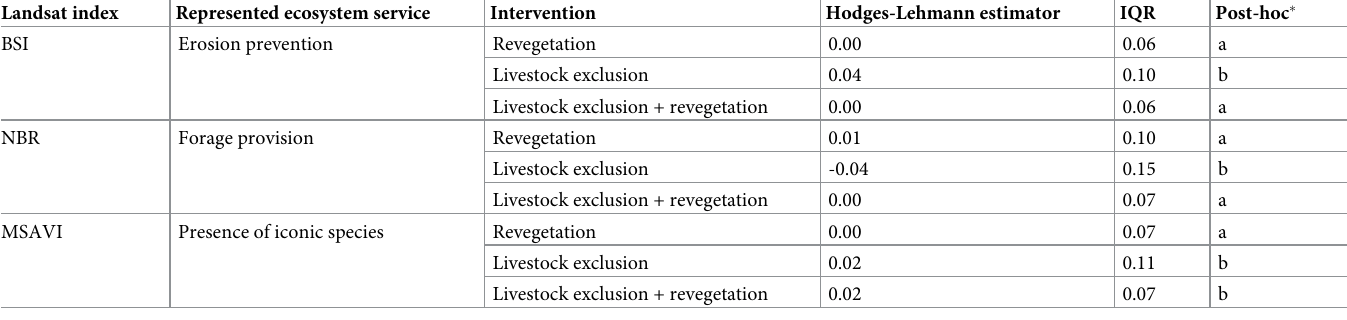
IQR = interquartile range. � different letters indicate significant differences of Games-Howell post-hoc at p-value <